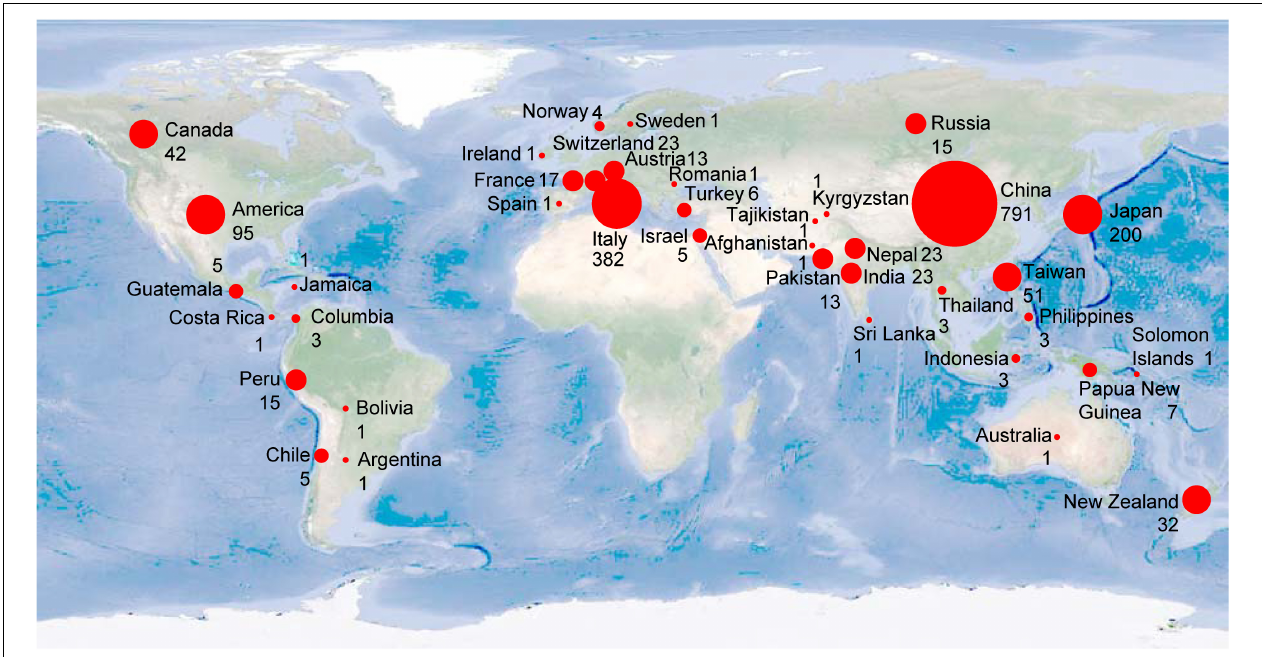
FIGURE 1 | Landslide dam distribution around the world. Red circles denote the proportion of landslide dams and the numbers are the total numbers of landslide dams in each